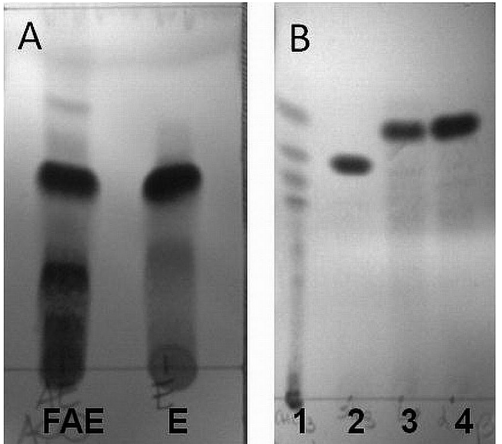
FIGURE 1 - Chromatographic profile of L. divaricata . Panel A: ethyl acetate fraction (SAE) and E, epicatechin. Panel B: chloroform fraction (SCHCl ) (1), stigmasterol (2), lupeol (3) 3 and α, β-amyrin